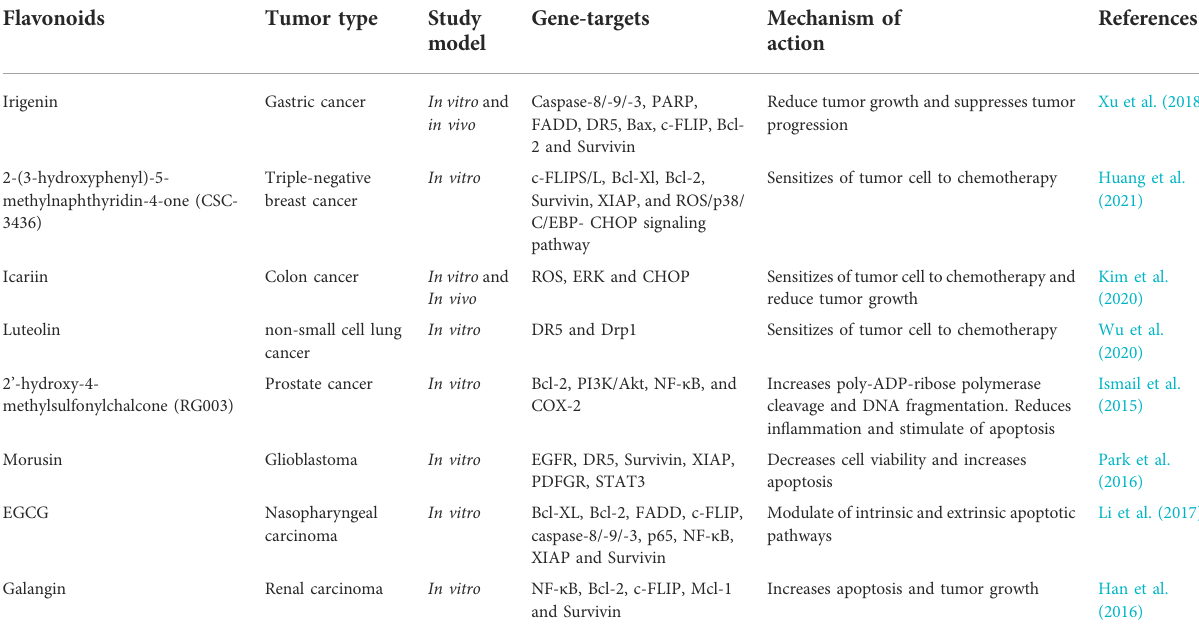
TABLE 5 The antitumor effects of fl avonoids by regulation the expression of TRAIL-induced